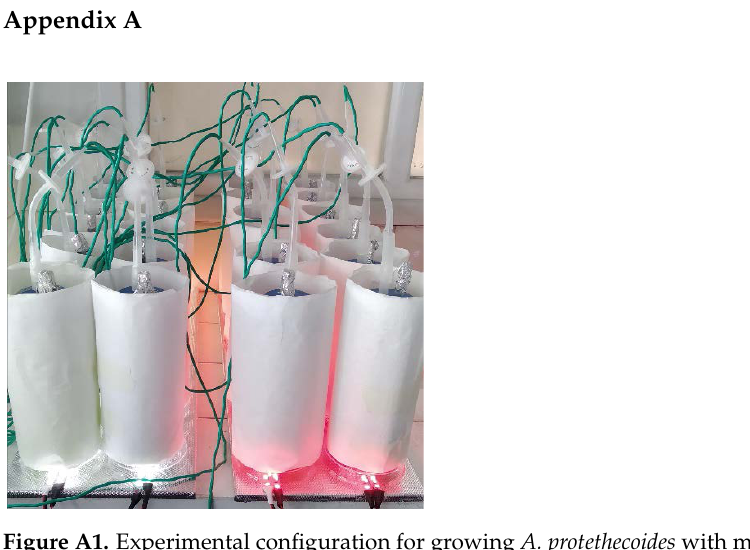
Figure A2. Spectra of the LEDs used for the illumination of the cultures of A . protothecoides and the associated absorption of the photosynthetically active pigments (chlorophyll a , chlorophyll b , and carotenoids). References 1.